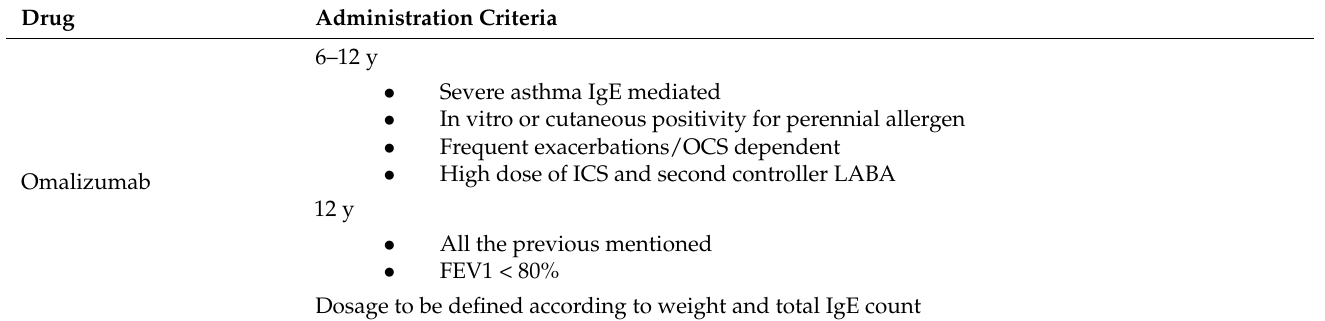
Table 1. Characteristics about prescribing criteria of MABs in severe